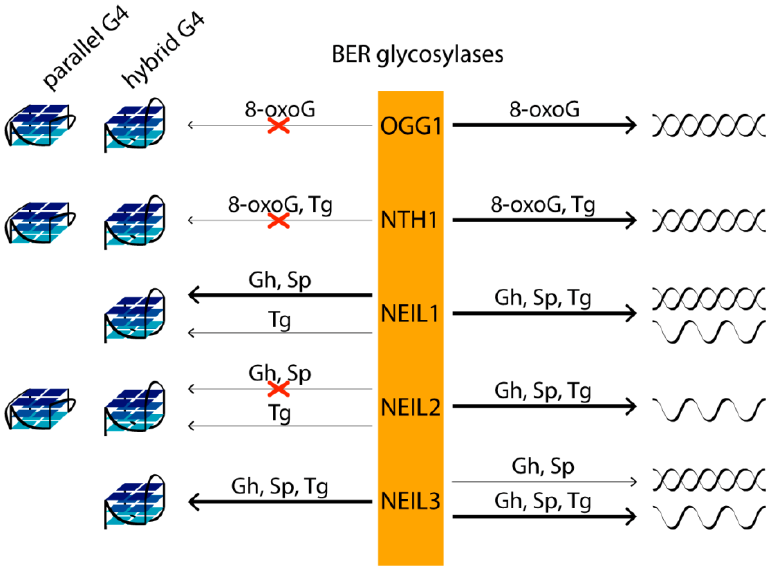
Figure 5. The relative preference of BER glycosylases toward oxidative guanine lesions in different structural contexts (various G4 topologies (left) versus single- and double-stranded DNAs (right)) as substrates for repair. The type of damage is shown above the arrows, the thickness of which reflects the repair efficiency: the thicker lines represent the better substrate, the thinner lines designate the relatively weaker enzyme activation, while the crossed arrows indicate the lack of the corresponding BER glycosylase activity against a specific oxidative lesion in a definite context.